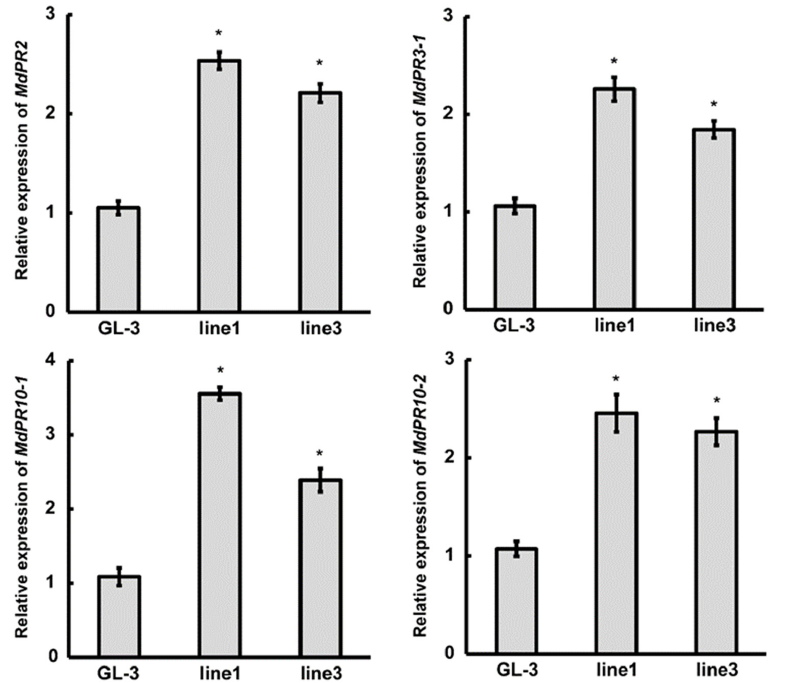
Figure 7. Expression analysis of disease-resistant marker genes in ‘GL-3 ′ and MIR390b -overexpressing plants. Leaves of 4-week-old ‘GL-3 ′ , MIR390b -line1, and MIR390b -line3 plants were harvested. Expression of PR2 , PR3-1 , PR10-1 , and PR10-2 was measured in control and transgenic apple plants by qRT-PCR. The vertical bars represent SDs ( n = 3). ‘*’ represents p < 0.05 (Student’s t -test).